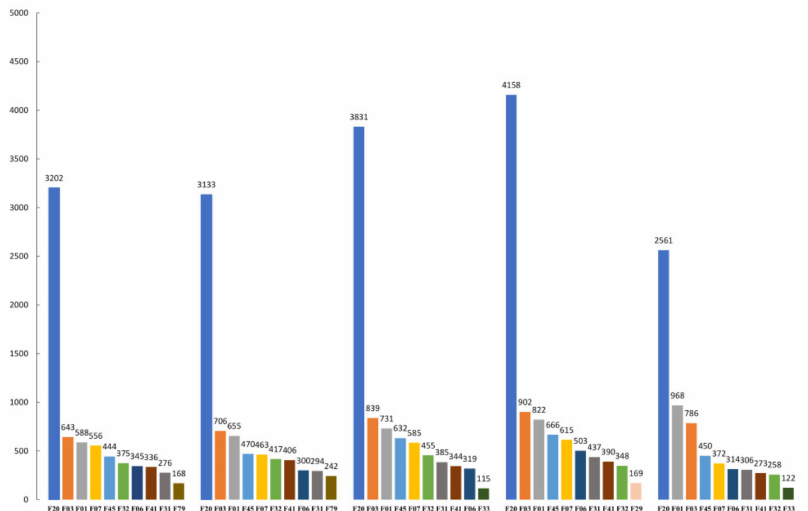
Figure 4. The top ten diseases for mental health service utilization at different years. Legend: The top ten diseases for mental health service utilization from January to July 2020 and the same period from 2016 to 2019. Note: F01, vascular dementia; F03, unspecified dementia; F06, other mental disorders due to brain damage and dysfunction and to physical disease; F07, personality and behavioral disorders due to brain disease, damage, and dysfunction; F20, schizophrenia; F31, bipolar affective disorder; F32, depressive episode; F33, recurrent depressive disorder; F41, other anxiety disorders; F45, somatoform disorders; F79, unspecified mental retardation.